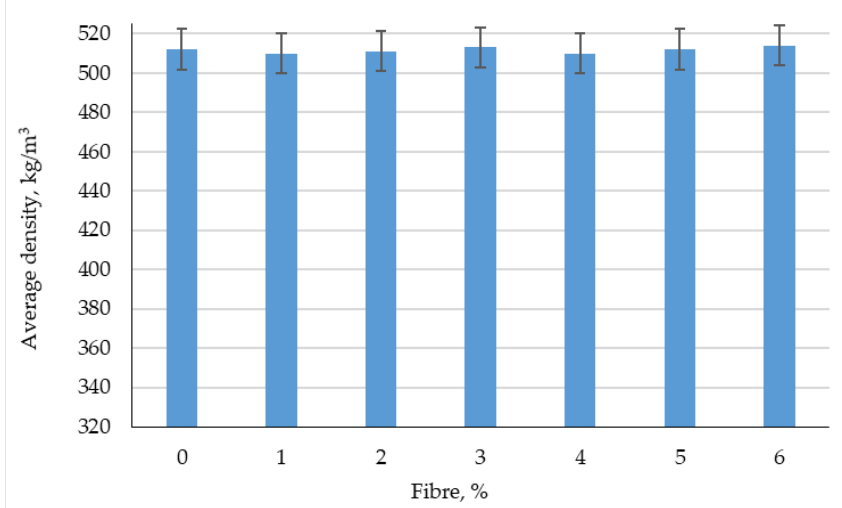
Figure 6. The results of experimental studies of the average density of prototypes of fiber foam concrete at various dosages of polypropylene fiber.